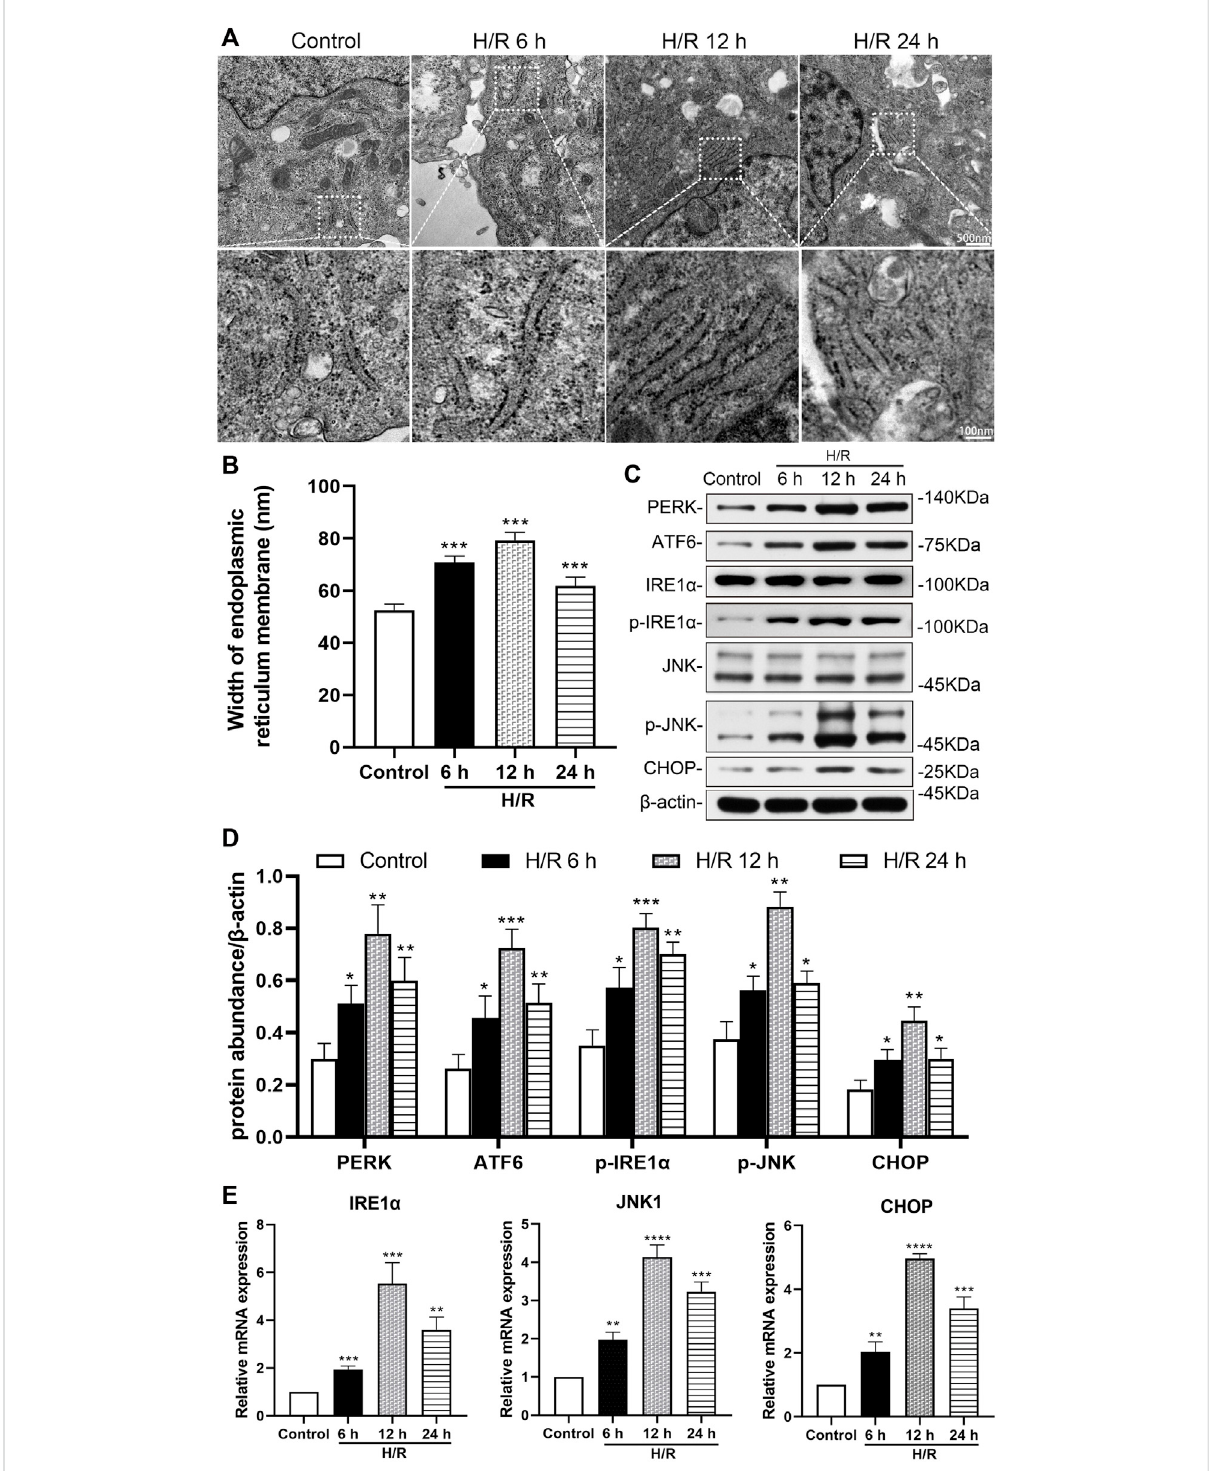
FIGURE 3 Detection of hypoxia/reoxygenation-induced ER stress in HK-2 cells at 6, 12, and 24 h after hypoxic for 4 h (A) Transmission electron microscopy was used to observe the ER of HK-2 cells (B) The analysis of the width of ER in HK-2 cells, detected by electron microscopy (C) Representative westernblottingofERstressmarkers (D) ProteinsynthesisofERstressproductioninwesternblotting (E) mRNAexpressionsofIRE1 α , JNK1, and CHOP in qRT-PCR. When the hypoxia/reoxygenation (H/R) groups were compared at 6, 12, and 24 h after H/R, the expression was highest at 12 h ( p < 0.0001). Statistical signi fi cance is denoted as *: p < 0.05, **: p < 0.01, ****: p < 0.0001 compared with the control group at the same time